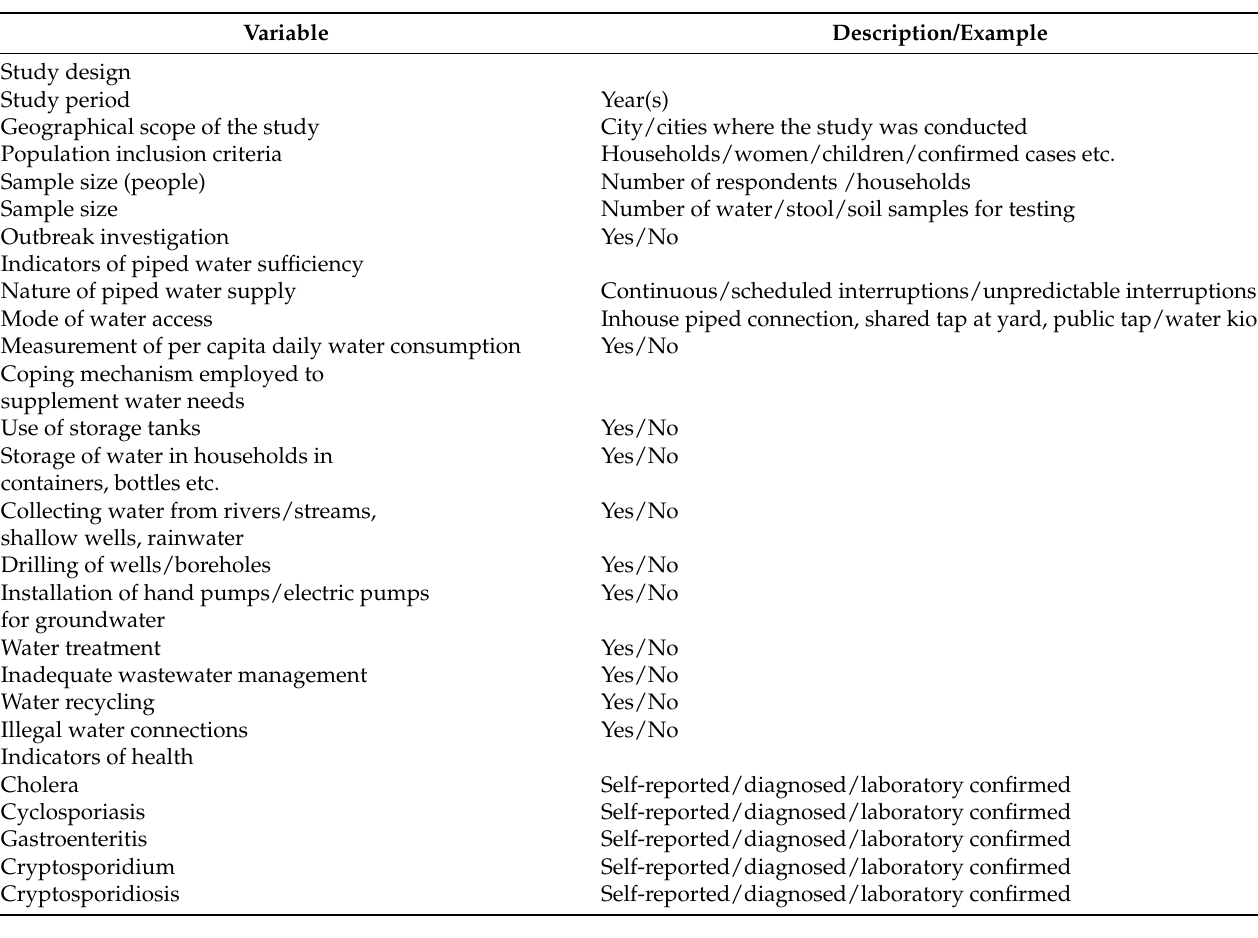
Table 1. Presentation of the variables extracted from the different articles during the full-text selection